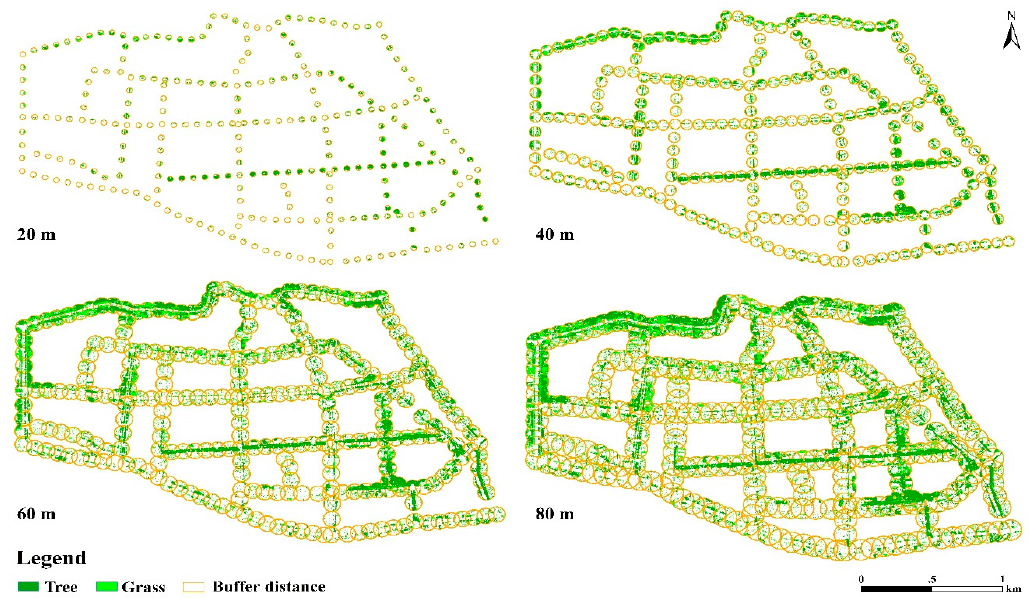
Figure 9. Green vegetation distribution at different buffer distances from 278 street sample sites in the study area.